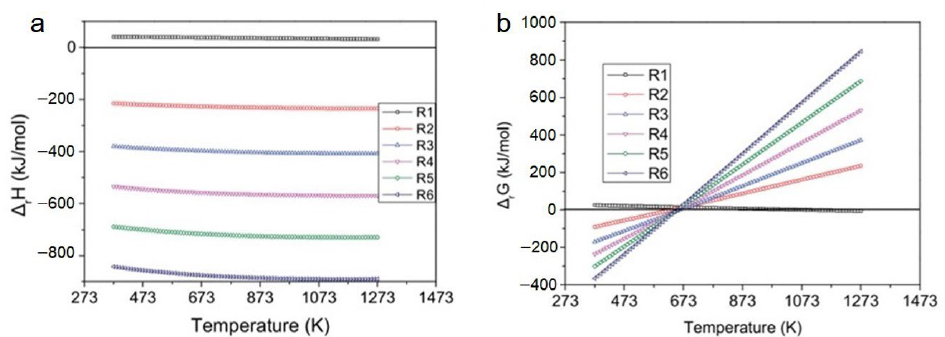
Figure 2. The ( a ) Δ r H and ( b ) Δ r G of related reactions (R1 represents the RWGS reaction: CO 2 + H 2 ↔ CO + H 2 O; R2 – R6 represents the reaction of n CO + 2 n H 2 → C n H 2 n + n H 2 O, n = 2, 3, 4, 5, 6). Re- printed with permission from ref. [50]. Copyright 2017